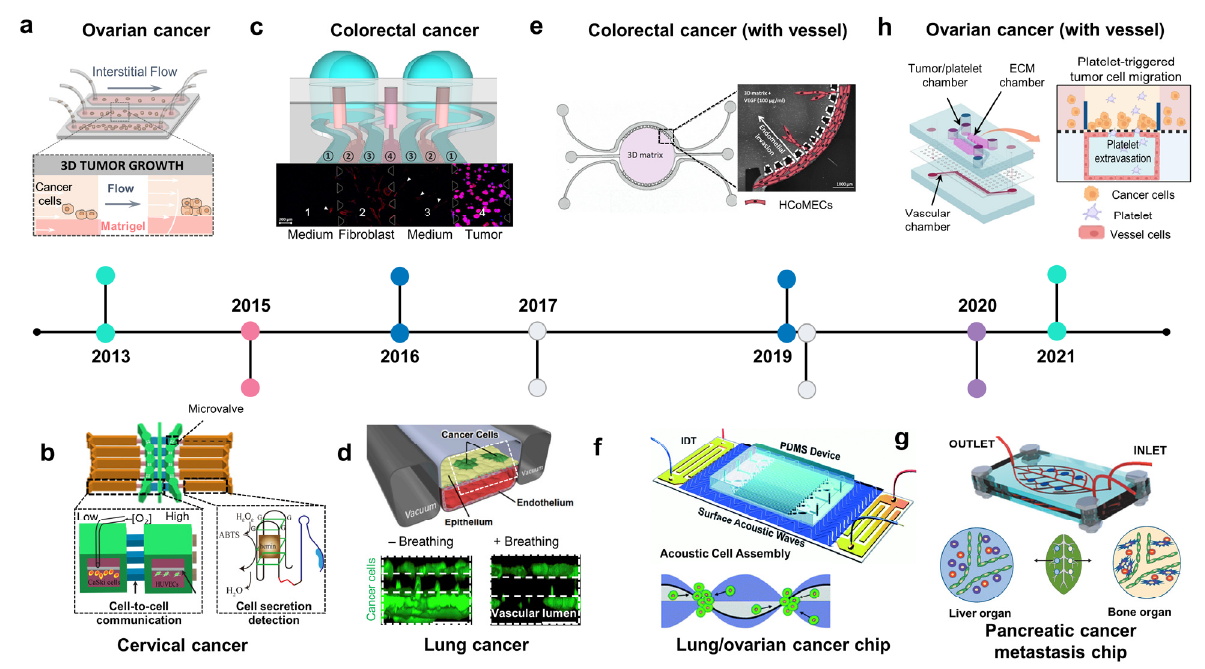
Figure 3. The development of organ-on-chip for studies of lung, digestive, and gynecologic cancer. ( a ) Ovarian cancer chip: the intestinal flow was applied to form a 3D ovarian tumor spheroid in a Matrigel-laden microchannel (adapted with permission from Ref. [89]. Copyright 2013, National Academy of Sciences). ( b ) Cervical cancer chip: cervical cancer on chip recreated low oxygen conditions to study the cell–cell interaction of cervical cancer cells and endothelial cells under hypoxia and detect secreted molecules from the cells (adapted with permission from Ref. [92]. Copyright 2015, CC BY 4.0). ( c ) Colorectal cancer chip: co-culture of human fibroblast and colorectal cancer showed the mobility of normal fibroblasts toward tumor cells (adapted with permission from Ref. [95]. Copyright 2016, CC BY 4.0). ( d ) Lung cancer chip: mechanical breathing inhibited the proliferation of lung cancer cells in an alveolar/bronchiolar chip (adapted with permission from Ref. [100]. Copyright 2017, Elsevier). ( e ) Colorectal cancer chip with a vessel: VEGF-produced colorectal tumor-inducing invasion of endothelial cells in a circular chip (adapted with permission from Ref. [97]. Copyright 2019, CC BY-NC 4.0). ( f ) Acoustofluidic ovarian/lung cancer chip: an acoustofluidics-based